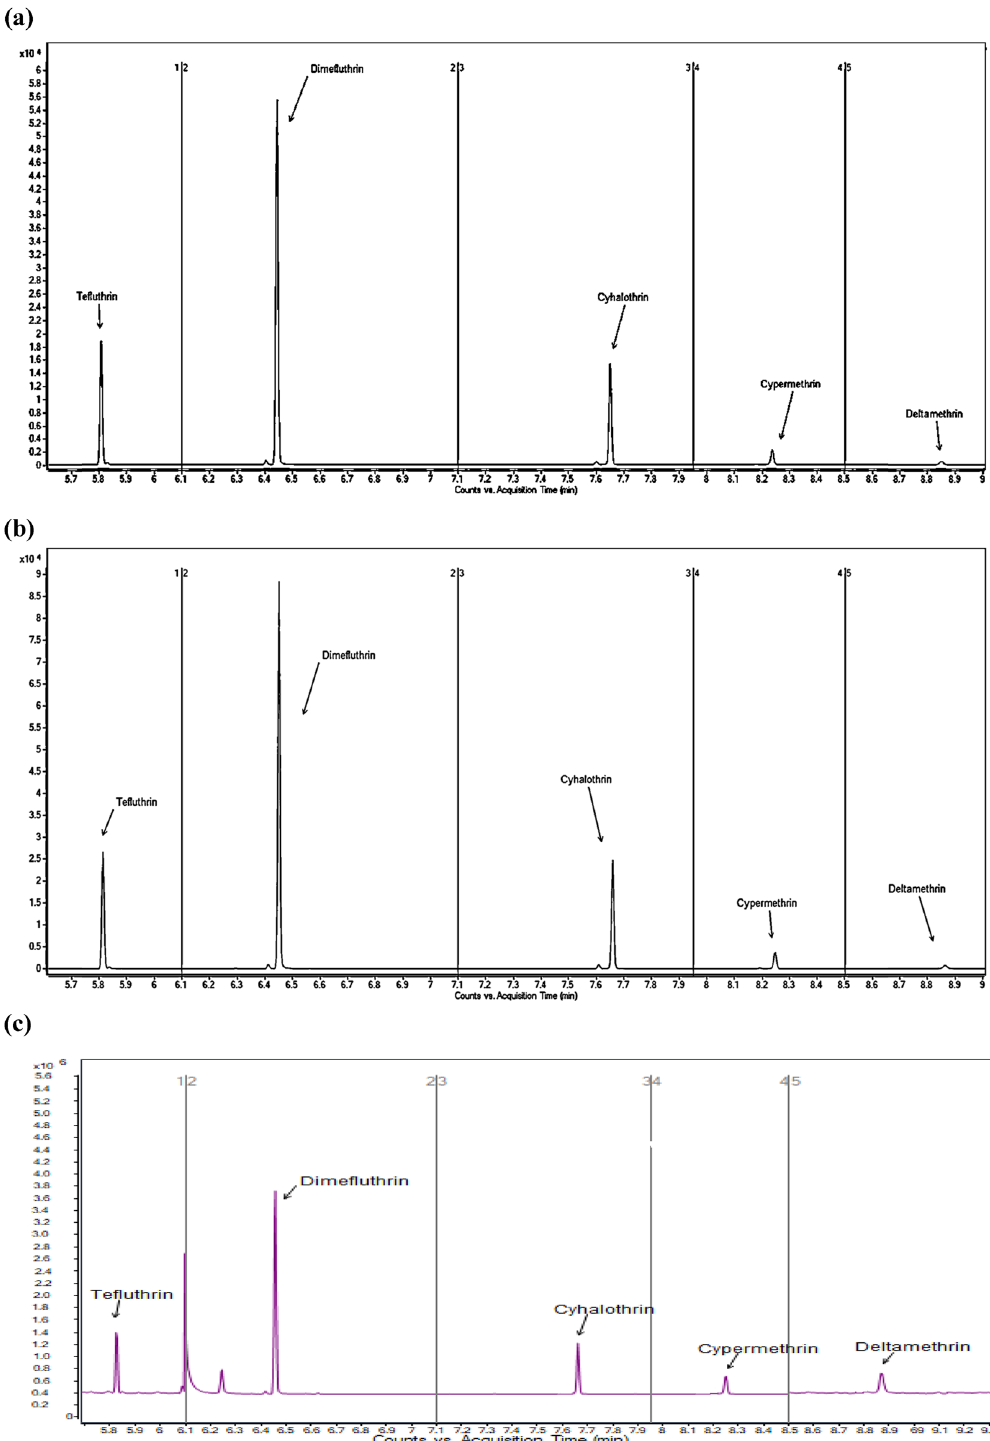
Figure 7: Chromatograms of spiked river water sample obtained by ( a ) direct injection, ( b ) LLE, and ( c )